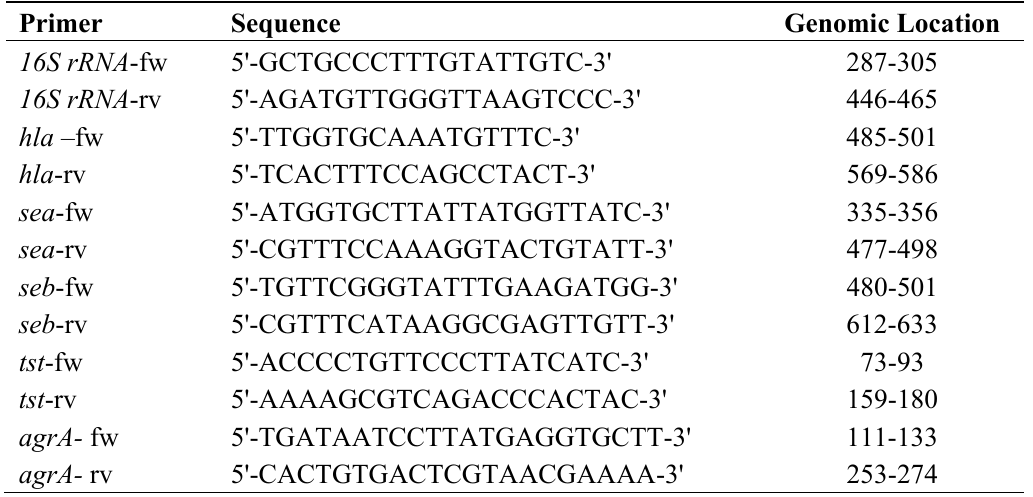
Table 4. Primers used for quantitative